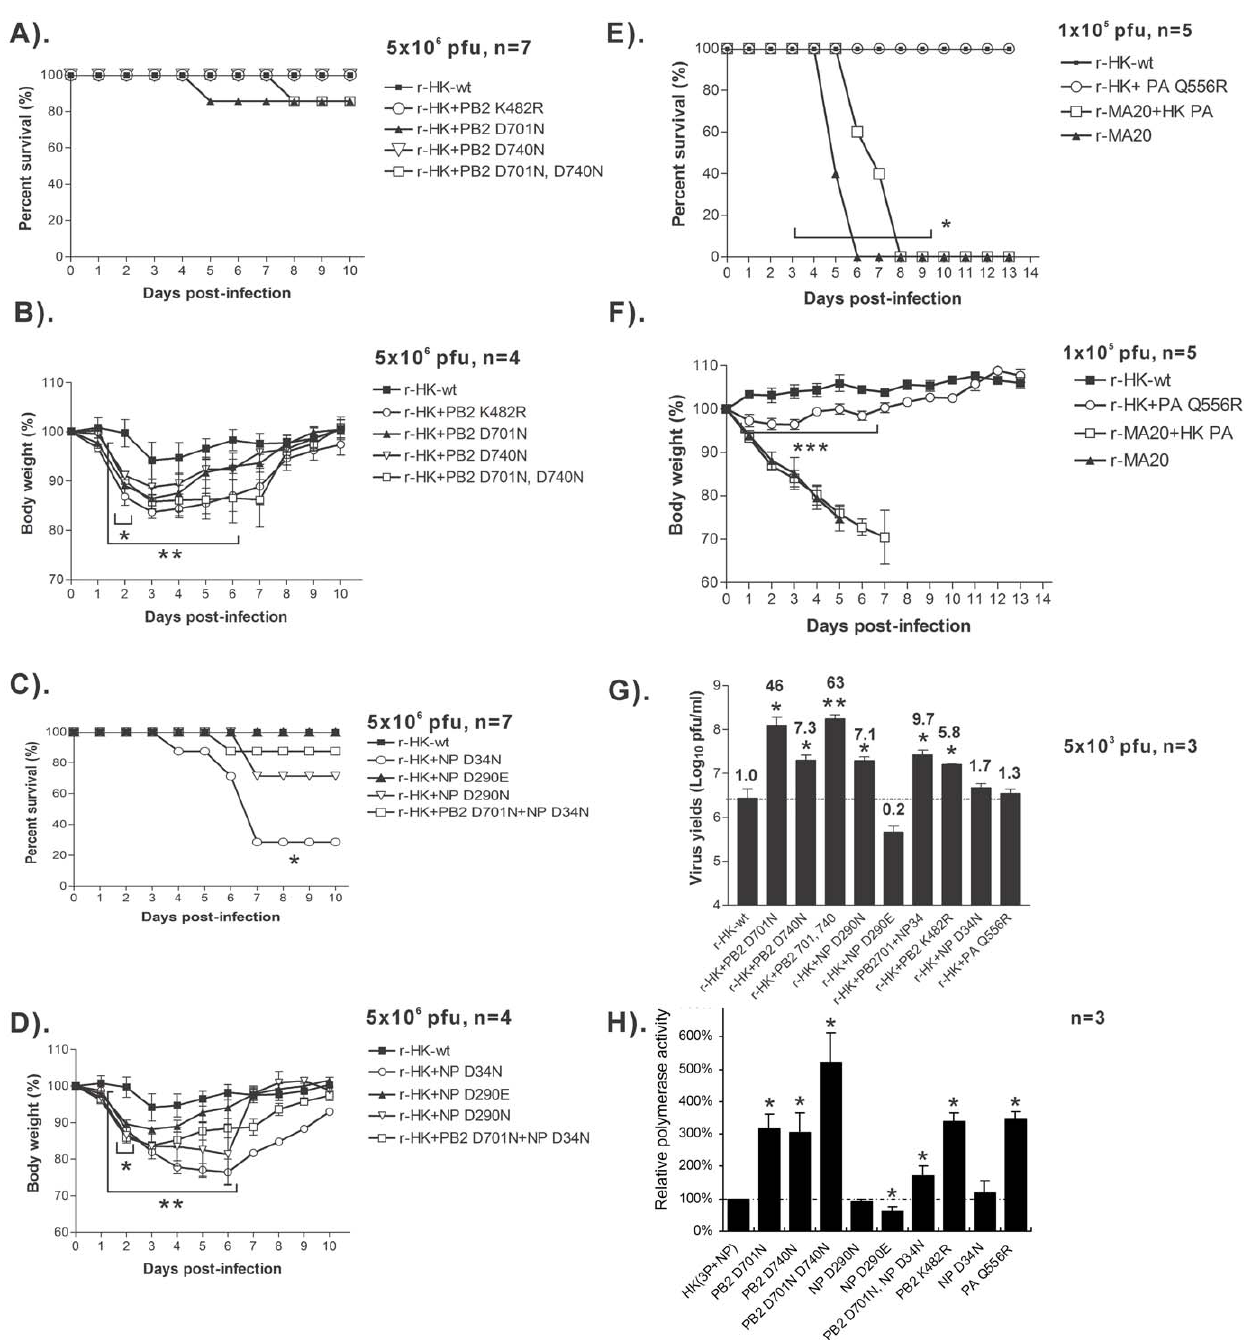
Figure 11. Assessment of the roles of PB2, PA and NP mutations in mouse models of virulence, replication and polymerase activity. Body weight and survival were monitored for groups of mice infected with recombinant HK viruses that possessed mouse adaptive mutations. (A and B), r-HK-wt and PB2 mutants, (K482R, D701N, D740N, D701N + D740N) were used to infect groups of 4 mice with 5 6 10 6 pfu of virus for body weight loss and with n=7 for survival. (C and D) r-HK-wt and mutant viruses with NP mutations D34N, D290N, D209E, or PB2 D701N + NP D34N were used as indicated to infect groups of 4 mice with 5 6 10 6 pfu of virus and with n=7 for survival. (E and F) r-HK and r-HK + MA20-PA (Q556R) as well as r-MA20 and r-MA20 + HK-wt-PA were used to infect groups of 5 CD-1 mice with 1 6 10 5 pfu of each with monitoring of weight loss and mortality. Weight loss was assessed relative to r-HK-wt infections using the single sample t-test at day 2 pi or using the paired t-test for 2–6 dpi; time to death was significant as indicated using student’s t-test, P , 0.05 indicated with *. (G) Replication in mouse lungs was monitored 1 dpi after infection of groups of 3 mice with 5 6 10 3 pfu each. The values are means of infections yields 6 SD for groups of 3 mice. (H) Polymerase activity was measured in mouse B82 cells for each of the indicated mutations relative to luciferase minigenome expression via a mouse POL1 polymerase by HK-wt plasmids expressing PB1, PB2, PA and NP and firefly luciferase driven by the NP promoter. Values are means 6 SD for n=3 samples. Statistical significance relative to HK-wt at the P # 0.05 and P # 0.01 are indicated with * and ** respectively.